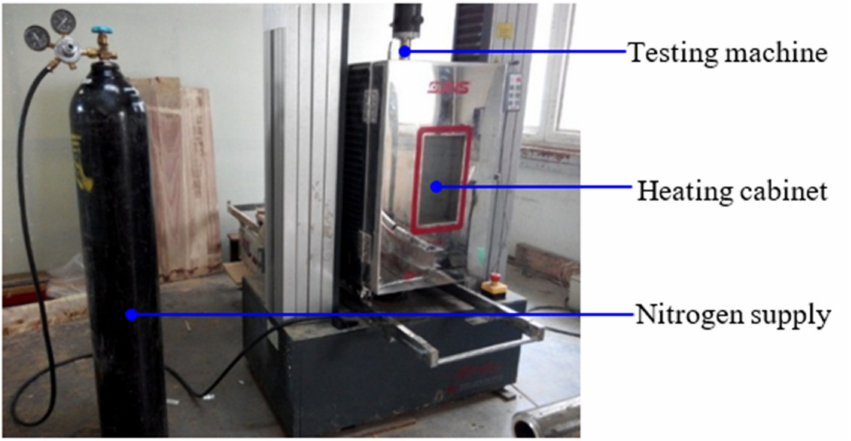
Figure 1. Test set-up for immediate bending strength at elevated and high